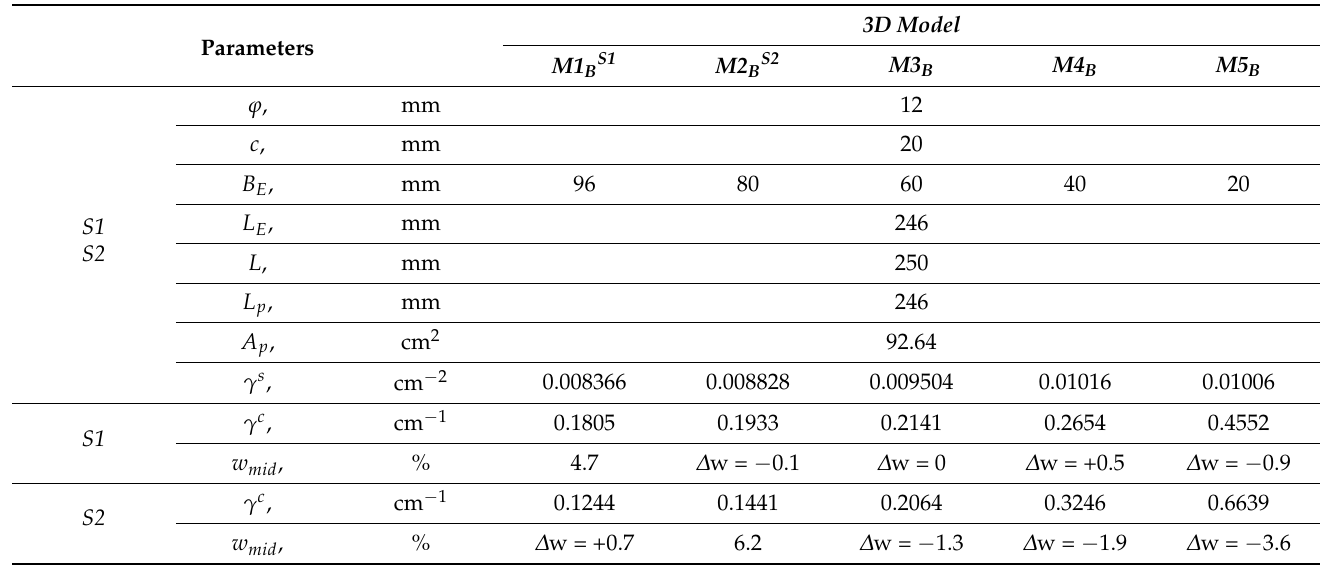
Table 1. Geometric parameters of the 3D model at a variable width B E of the counter electrode and average moisture content in concrete considered in the computational analysis of impedance spectra of steel in concrete of series S1 and S2 .